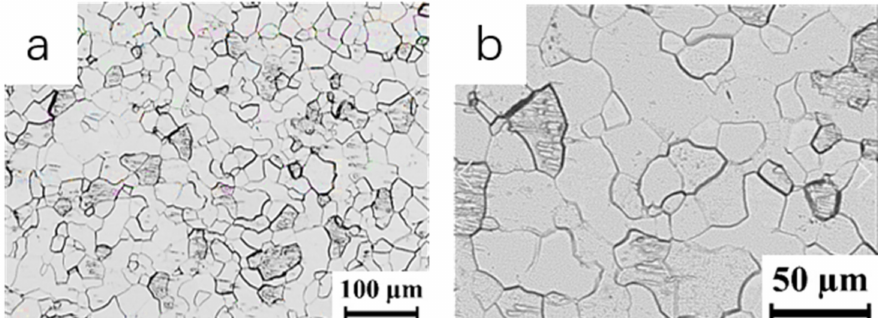
Figure 1. Initial microstructure of TA2 alloy sheet before cold deformation. ( a ) 200 × ( b ) 500 × .